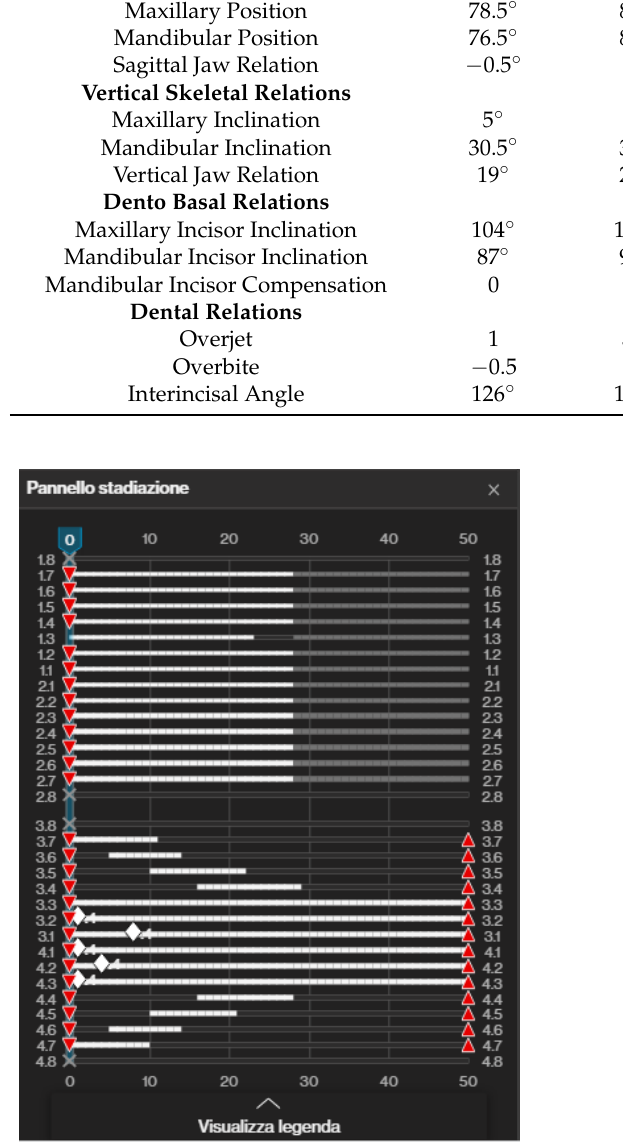
Figure 3. Invisalign ® (Align Technology, Tempe, AZ, USA) software staging table where it is possible to appreciate the “ladder” scheme of distalization. In the upper arch all teeth were moved at the same time. In the lower arch, lower teeth were distalized in a sequential way, while anterior teeth were moved from the beginning. Red triangles mean that all teeth had